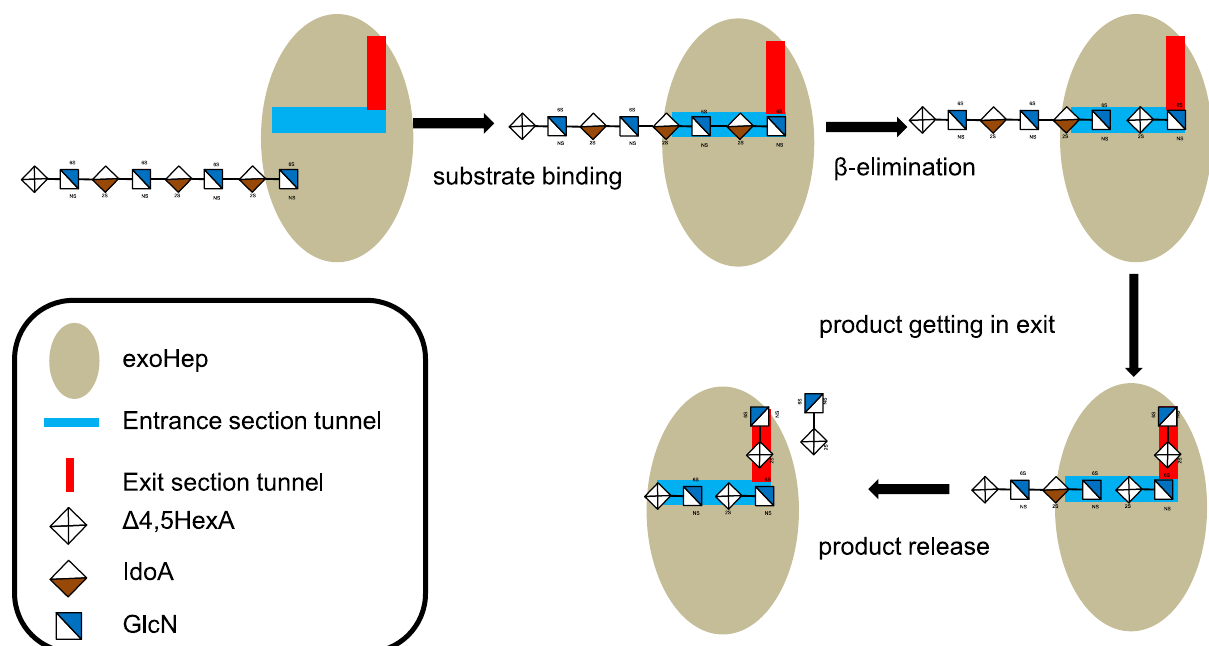
Fig. 5 Schematic diagram of the proposed exolytic mode of BIexoHep. The exolytic mode of BIexoHep is proposed as: fi rst, the reducing end of the free HP chain in the environment binds to the positively charged entrance of the L-shaped tunnel via charge attraction; then the bound HP chain moves into the tunnel, and the reducing end disaccharides are cleaved via a β -elimination mechanism; fi nally, the resulting disaccharide product is pushed into the negatively charged exit and rapidly